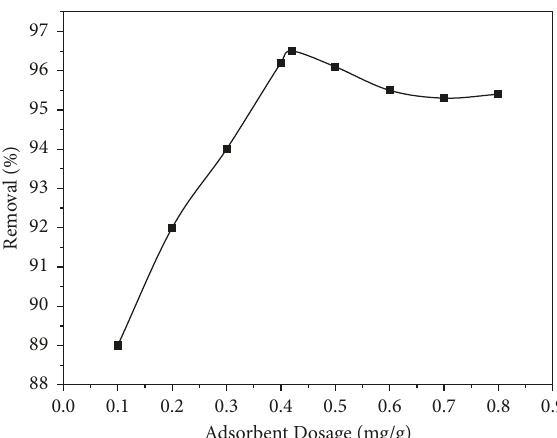
Figure 11: Effects of initial fluoride concentration.